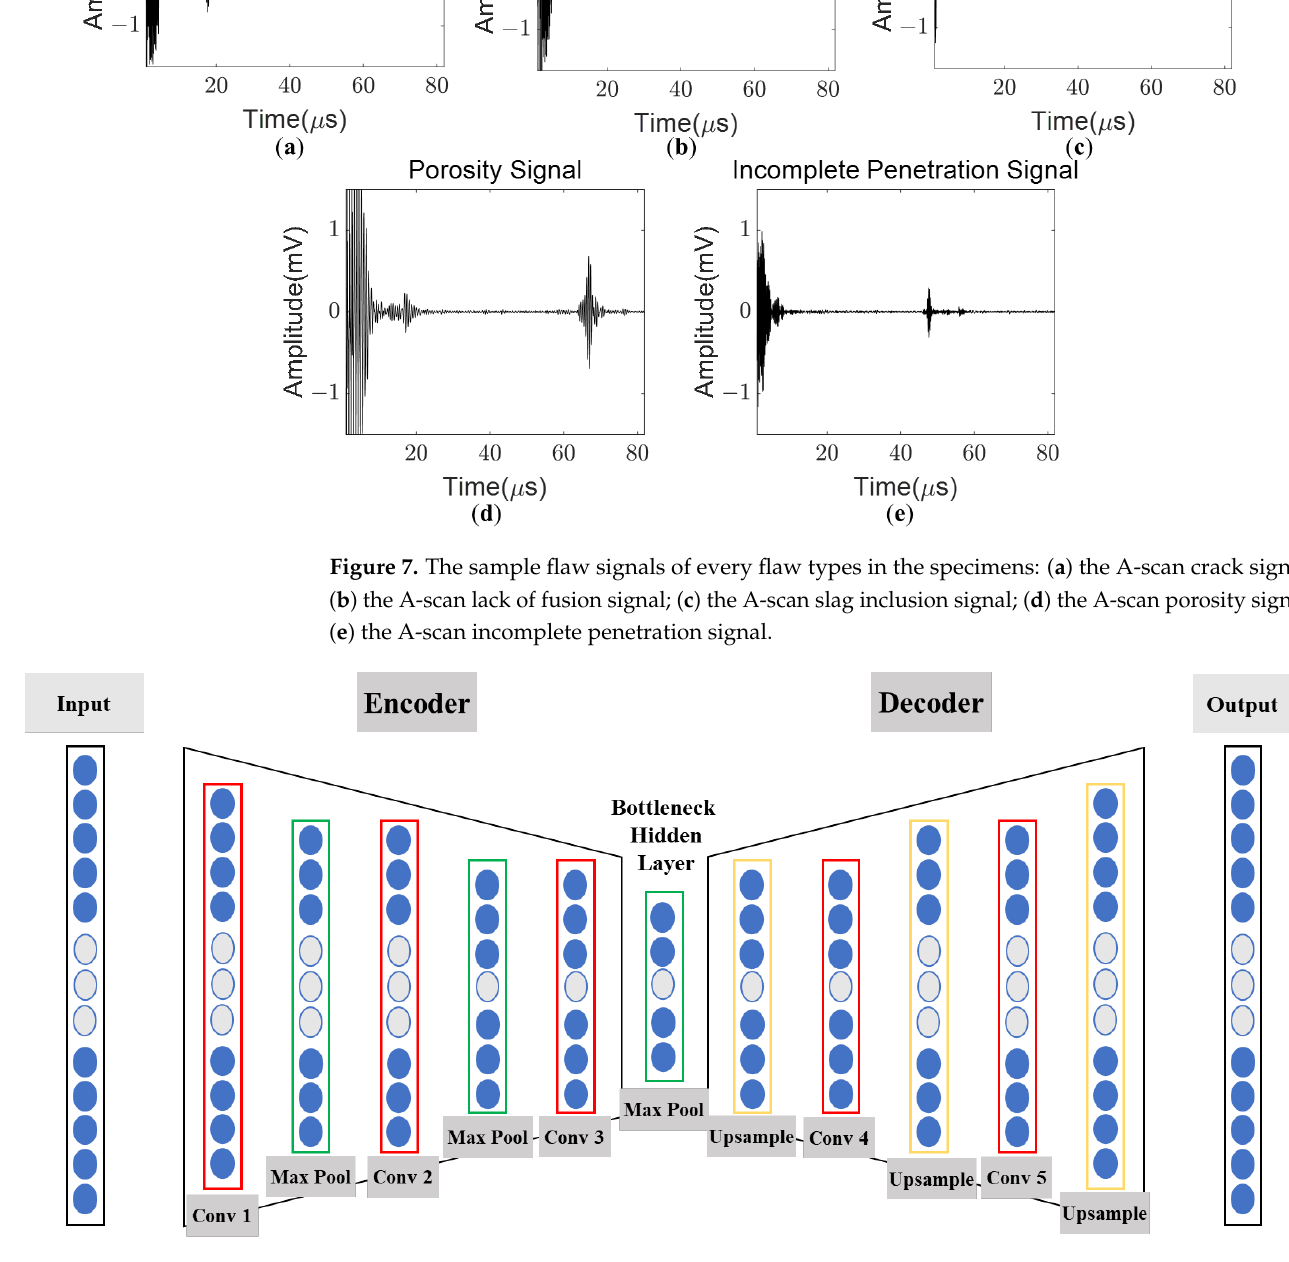
Figure 8. The diagram of training procedure for the proposed DAE used in this study.